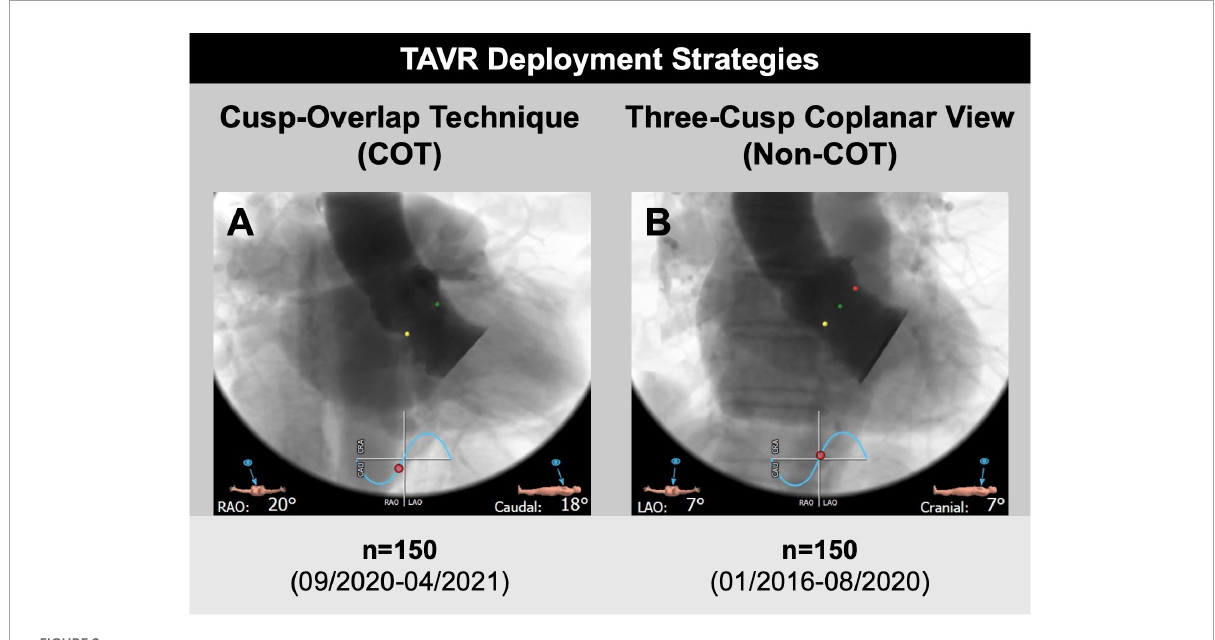
FIGURE2 Transcatheter aortic valve replacement (TAVR) deployment strategies. (A) A total of 150 patients undergoing transfemoral TAVR with self-expandable Medtronic CoreValve Evolut prostheses and cusp-overlap deployment technique (COT) were compared to (B) 150 propensity-matched patients with application of a conventional three-cusp coplanar view only (Non-COT). The cusp-overlap view was generated by overlapping the right coronary cusp (RCC, green dot) and left coronary cusp (LCC, red dot) with isolation of non-coronary cusp (NCC, yellow dot), leading to reduction of parallax in the device and elongation of the left ventricular outflow